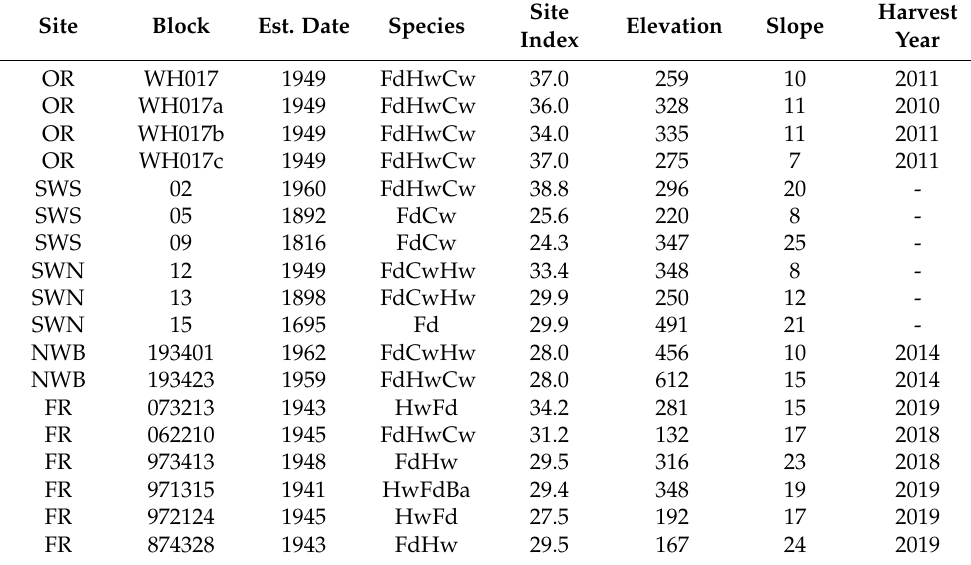
Table 1. Sample block site descriptions including earliest estimated establishment date (Est. Date), major species composition, main stand estimated site index (m) (site height at 50 years age at DBH), average block elevation (m ASL), average block slope (degrees) for blocks located at the Oyster River (OR), Sooke Lake Watershed South (SWS), Sooke Lake Watershed North (SWN), Northwest Bay (NWB), and Franklin River (FR) sites. Major species include Douglas-fir (Fd), western hemlock (Hw), western red cedar (Cw), and amabilis fir (Ba). Est. Date determined through tree core analysis at OR, SWS, SWN and through existing forest inventories at NWB and